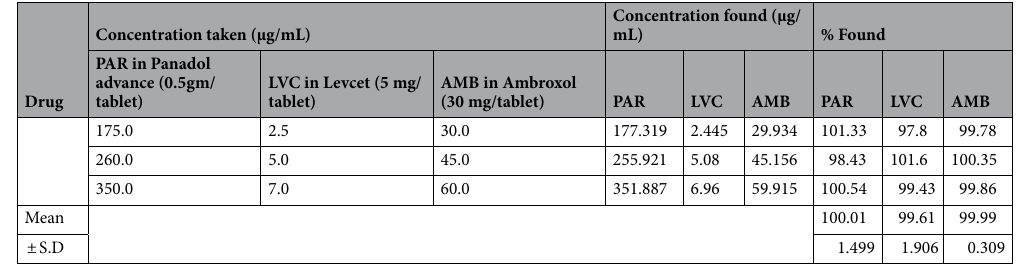
Table 7. Assay results for the determination of some of the studied drugs in their single dosage form by the suggested HPLC